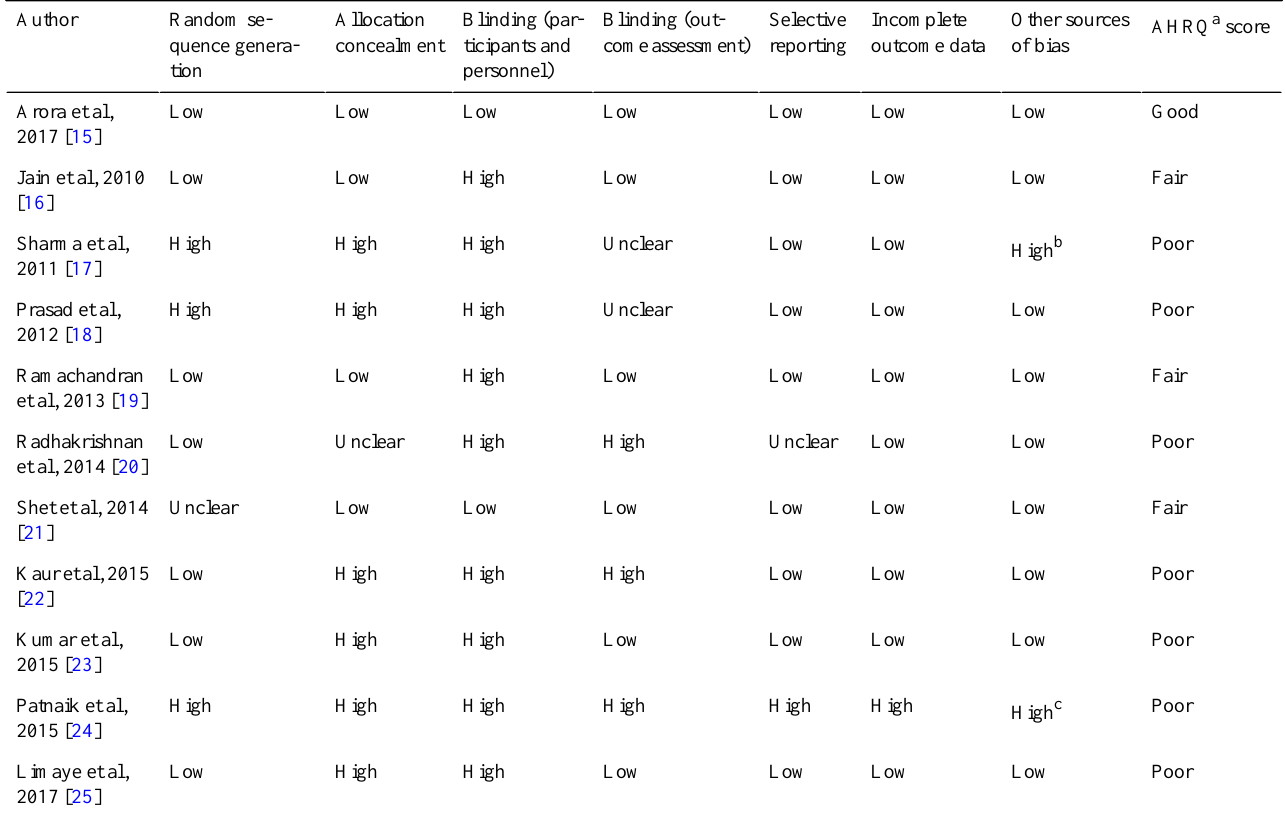
Table 2. Risk of bias assessment for randomized control trials.